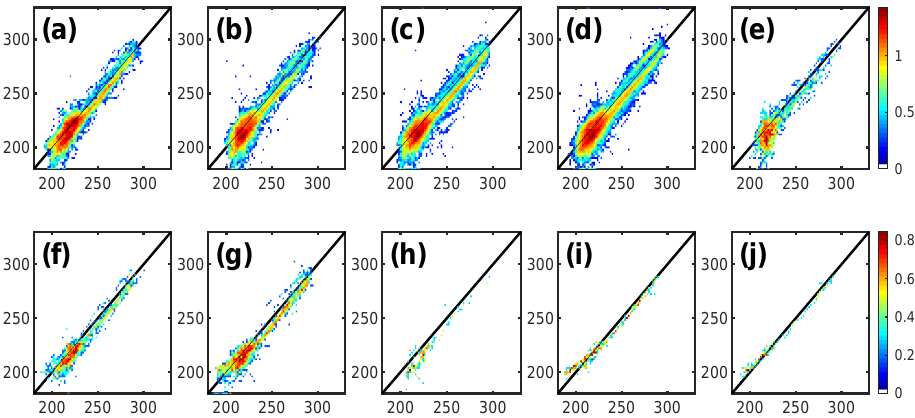
Figure 7. The 2D-histogram plot of the FY4A temperature and radiosonde temperature under the 9 ISCCP cloud types and clear-sky condition. x-axis is the radiosonde temperature, y-axis is FY4A temperature. Units are in K. The cases with QC flags of “bad” or “very bad” in the vertical range of 10 hPa to surface are selected. 10 sky conditions are in the 10 sub-figures: ( a ): clear, with PCC of 0.9939, ( b ): cirrus, with PCC of 0.9000, ( c ): cirrostratus, with PCC of 0.9169, ( d ): deep convection, with PCC of 0.9174, ( e ): altocumulus, with PCC of 0.9102, ( f ): altostratus, with PCC of 0.9463, ( g ): nimbostratus, with PCC of 0.9072, ( h ): cumulus, with PCC of 0.9314, ( i ): stratocumulus, with PCC of 0.9804, ( j ): stratus, with PCC of 0.9925. All the correlation coefficients are at 95% confidence level. The colors represent the frequency 10 n where n is the value in colorbar. The black line is the identity